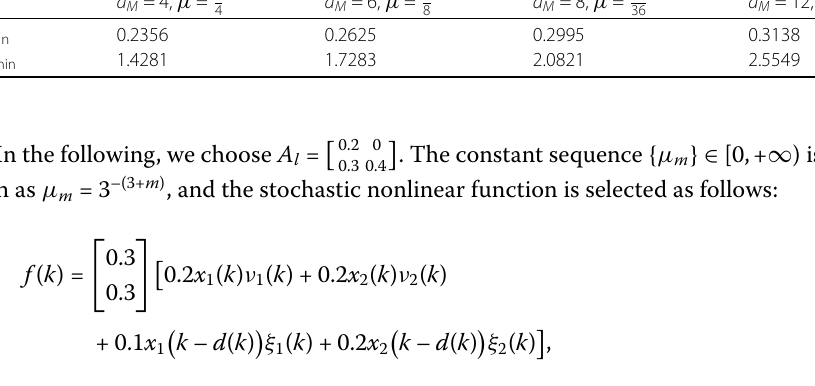
Table 2 Optimal values for different upper bound d M and ¯ μ d M = 4, ¯ μ = 1 d M = 6, ¯ μ = 1 d M = 8, ¯ μ = 1 d M = 12, ¯ μ = 1 4 8 36 54 γ min 0.2356